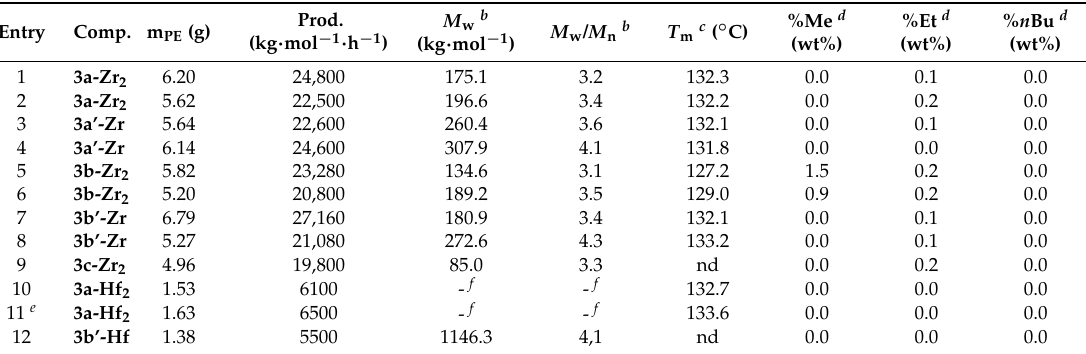
Table 1. Homopolymerization of ethylene a .